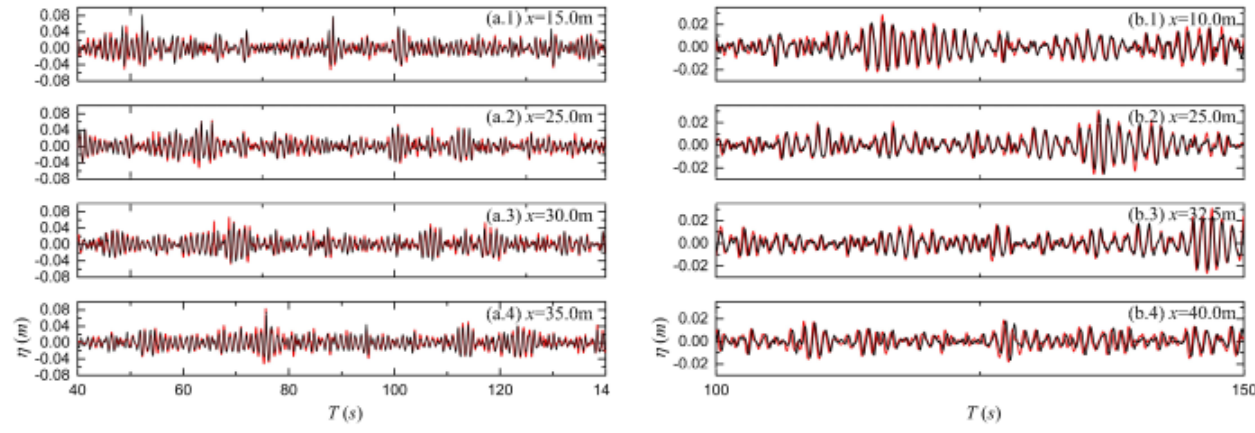
Figure 3. Comparisons of the surface elevations between the experimental data (black solid lines) and the numerical results (red solid lines) for Case A ( left ), and Case B ( right